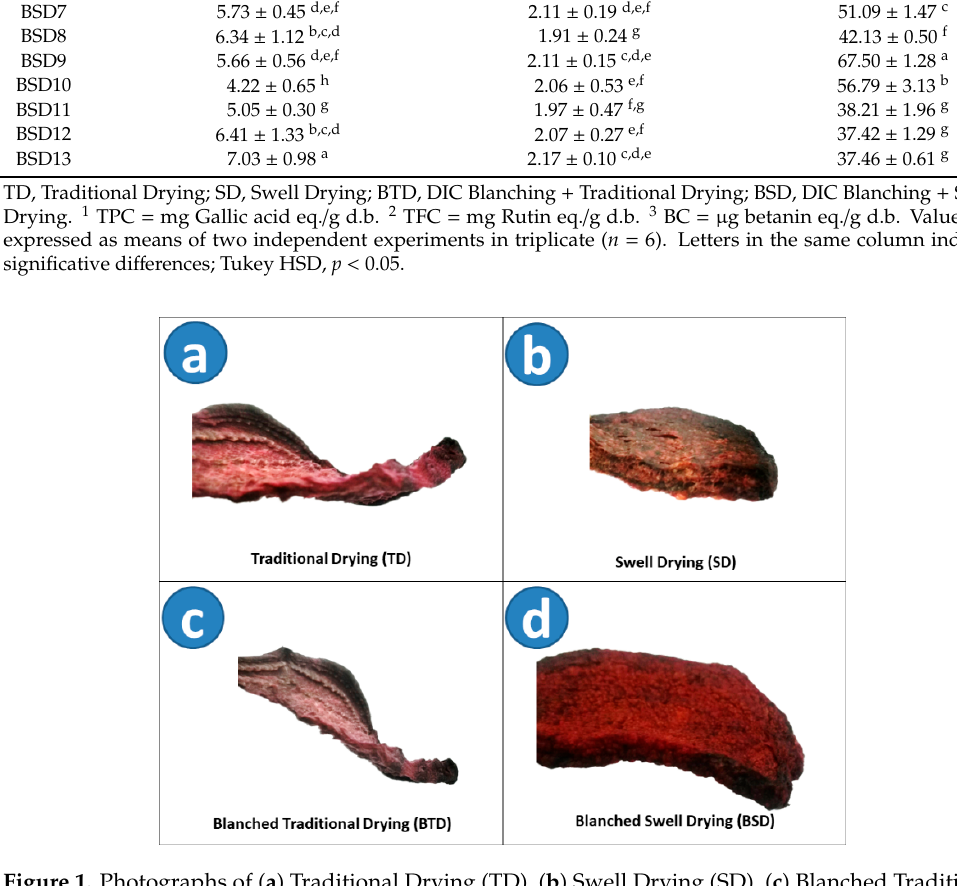
Figure 1. Photographs of ( a ) Traditional Drying (TD), ( b ) Swell Drying (SD), ( c ) Blanched Traditional Drying (BTD), and ( d ) Blanched Swell Drying (BSD) of red beetroots.